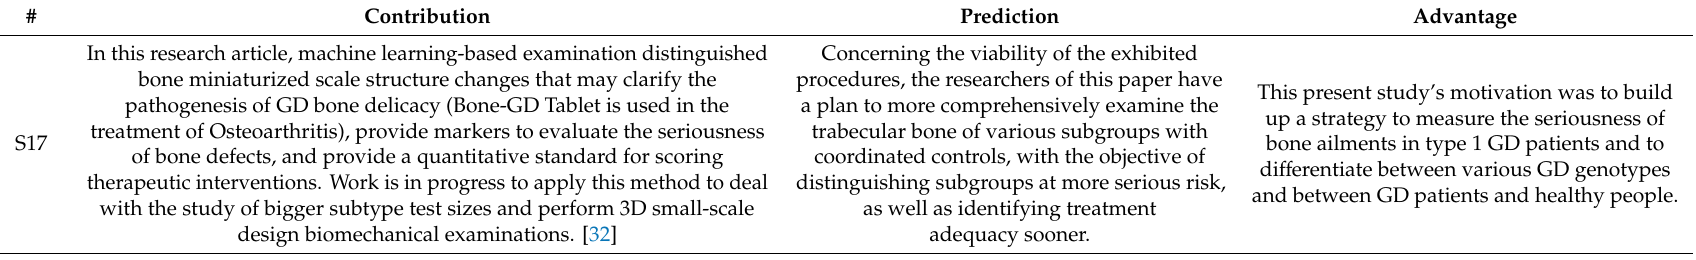
Table 12. Extracted data from papers including the contributions, predictions and advantages of related Machine Learning